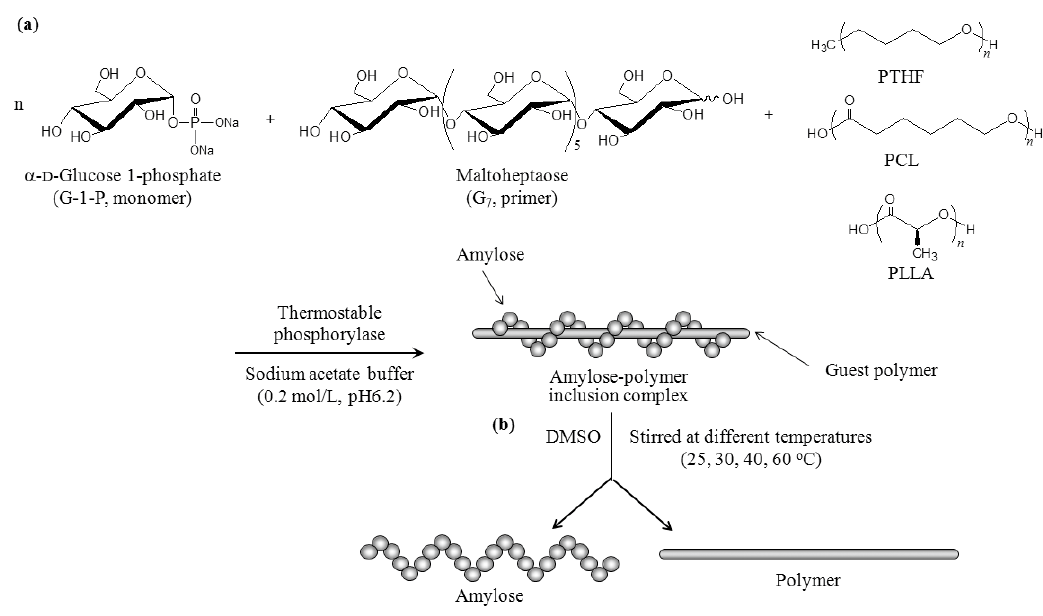
Figure 1. Preparation of: ( a ) inclusion complexes by vine-twining polymerization using polytetrahydrofuran (PTHF), poly( ε -caprolactone) (PCL), and poly(l-lactide) (PLLA) as guest polymers and ( b ) their dissociation under solution state in dimethyl sulfoxide (DMSO).